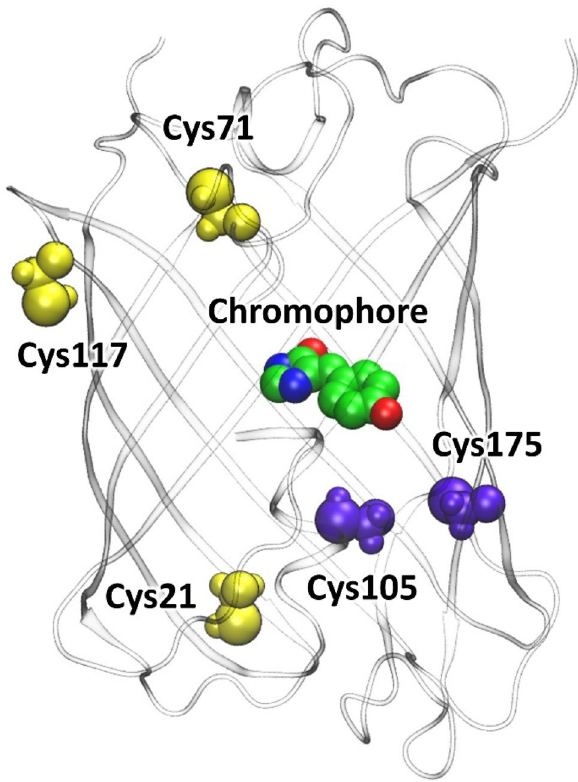
Figure 1. The calculated 3D structure of SAASoti fluorescent protein. The chromophore is colored by atom type (here and on the next figures carbon is green, oxygen—red, nitrogen—blue and hydrogen—white). The cysteine residues mutated in this study are colored in yellow if the side chain is oriented to the solution and in violet if the side chain is inside the β-barrel.